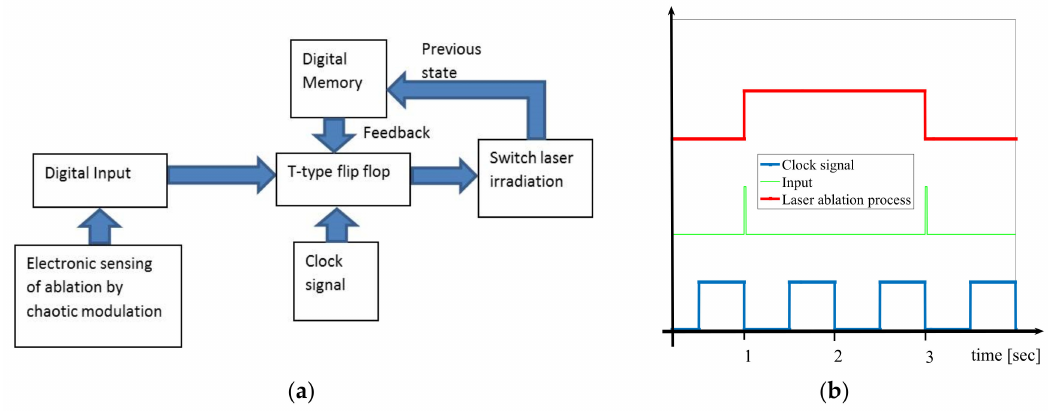
Figure 2. ( a ) Procedure diagram for fulfilling a complete laser ablation process controlled by a T-type flip-flop with a steady-state Rössler attractor as an input signal. ( b ) Chronogram showing the logic digital response during the evolution of laser ablation of the region irradiated. The input is provided by the optoelectronic sensor with chaotic modulation. The clock signal is strobed by a descendent edge trigger in order to avoid